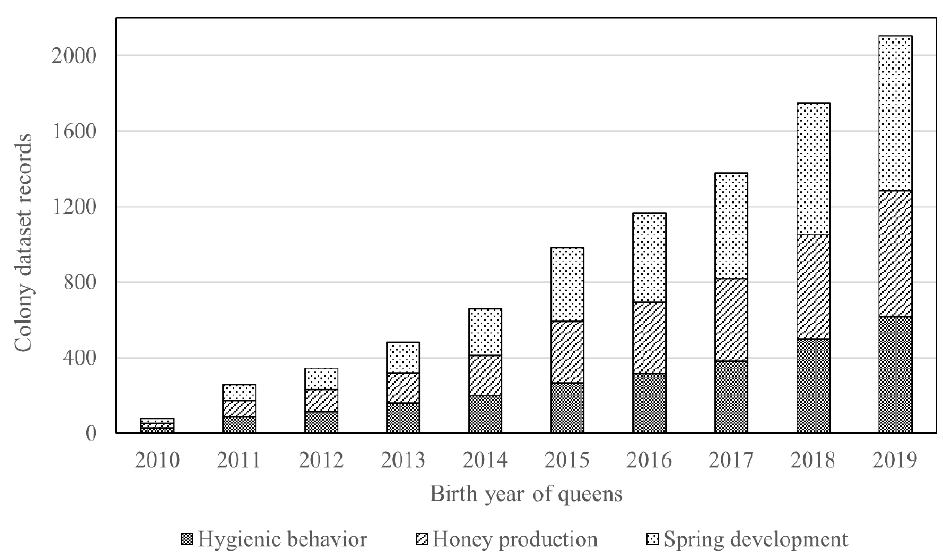
Figure 3. Development of the databank for the performance of hygienic behavior, honey produc- tion and spring development traits used to calculate breeding values in the UL-CRSAD honeybee breeding program.